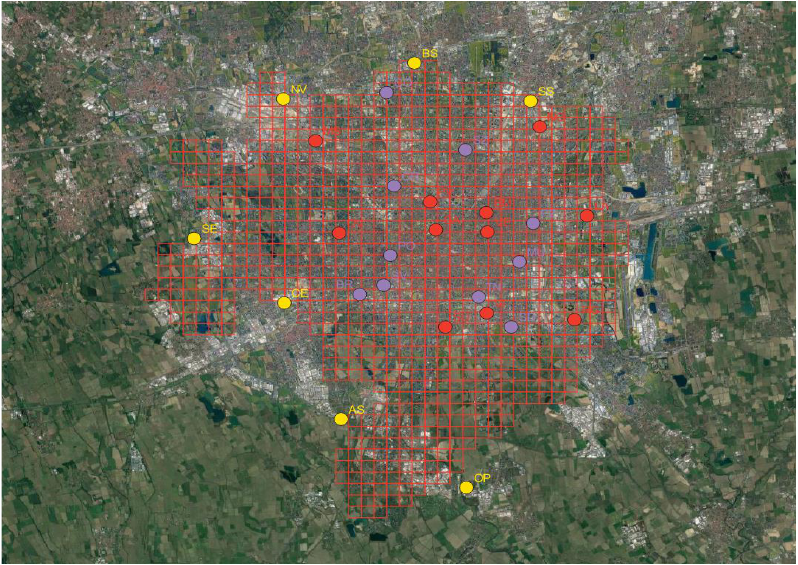
Figure 7. Location of the PSs and MV substations feeding Milano and Rozzano. Red points are PSs owned by Unareti; Yellow points are PSs belonging to the competitor DSO; MV substations are in purple.